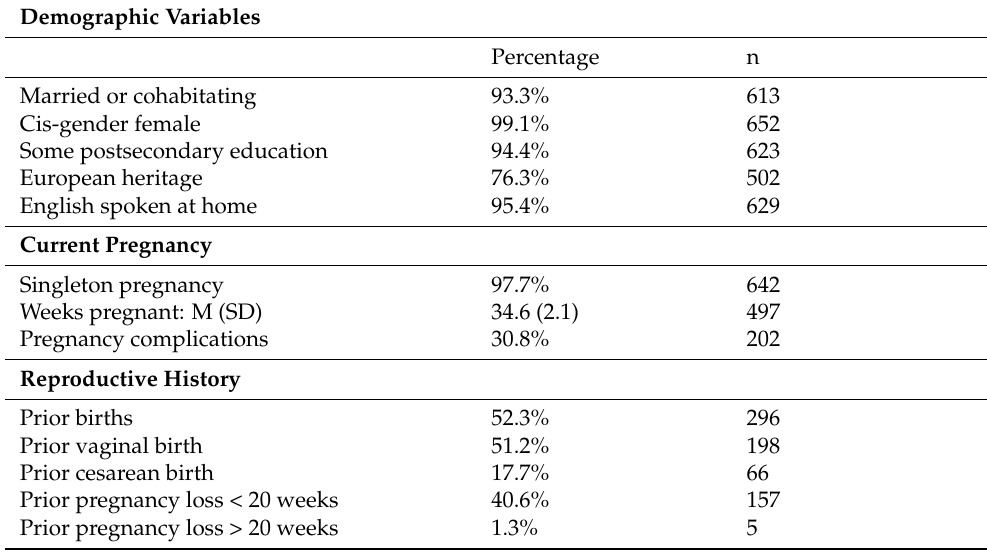
Table 1. Participant demographic information and reproductive information (N = 659).